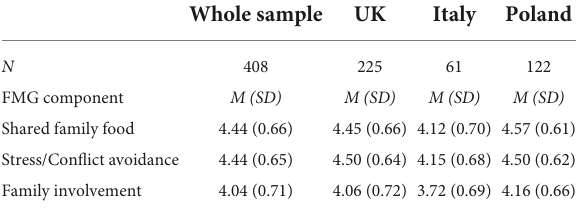
TABLE 3 Family mealtime goals questionnaire component scores for parents in the UK, Italy, and Poland. Whole sample